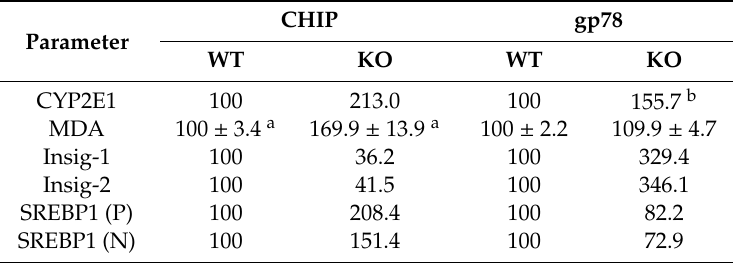
Table 1. Relative hepatic CYP2E1-, Insig 1 / 2- and SREBP1c-content and MDA-levels of CHIP- and gp78-knockout (KO)